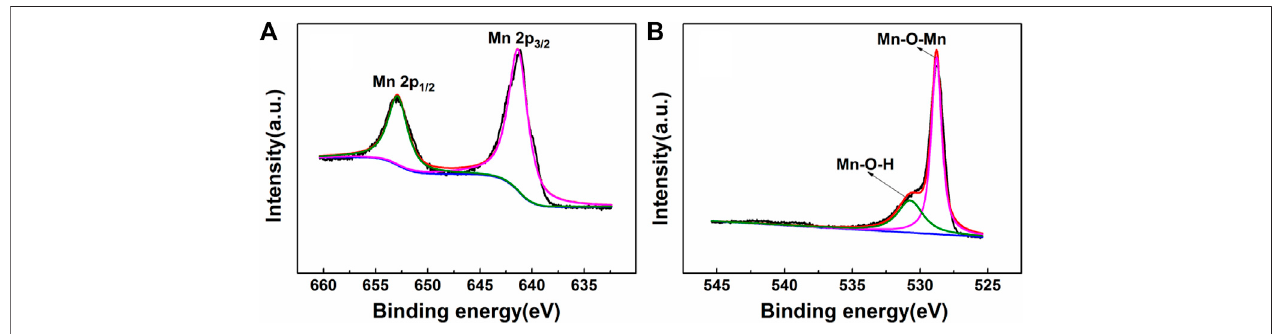
FIGURE 3 | The XPS spectra of (A) Mn 2p and (B) O 1